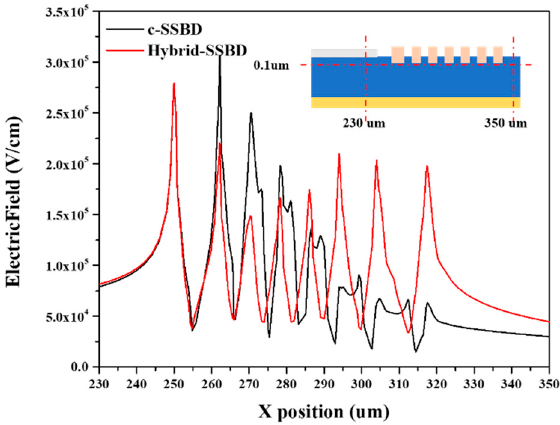
Figure 6. The electric field distribution at the depth of 0.1 µ m under the device surface for c- SSBD and Hybrid-SSBD at a reverse bias of 1500 V. The insert graph represents the position in the device structure.